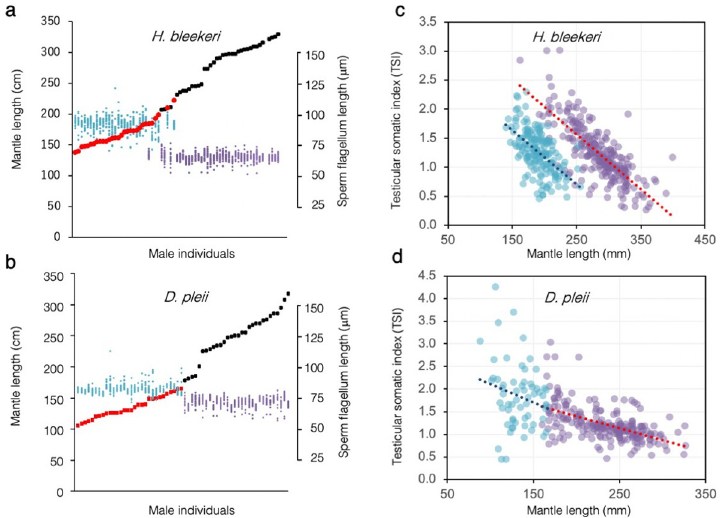
Fig 3. Changes in sperm FL and reproductive indices among individuals associated with size distribution in H . bleekeri and D . pleii . Male individual measurements in FL are arranged in order of increasing mantle length. For each male individual in H . bleekeri (a) and D . pleii (b), ML ( closed circles ) and FL values of 20 spermatozoa ( scattered dot s) have been plotted. The colour code represents sneaker males ( cyan and red ) or consort males ( purple and black ). Relationship between the mantle length and relative testis mass (testicular somatic index; TSI) in sneaker ( cyan ) and consort ( purple ) individuals are plotted for H . bleekeri (c) and D . pleii